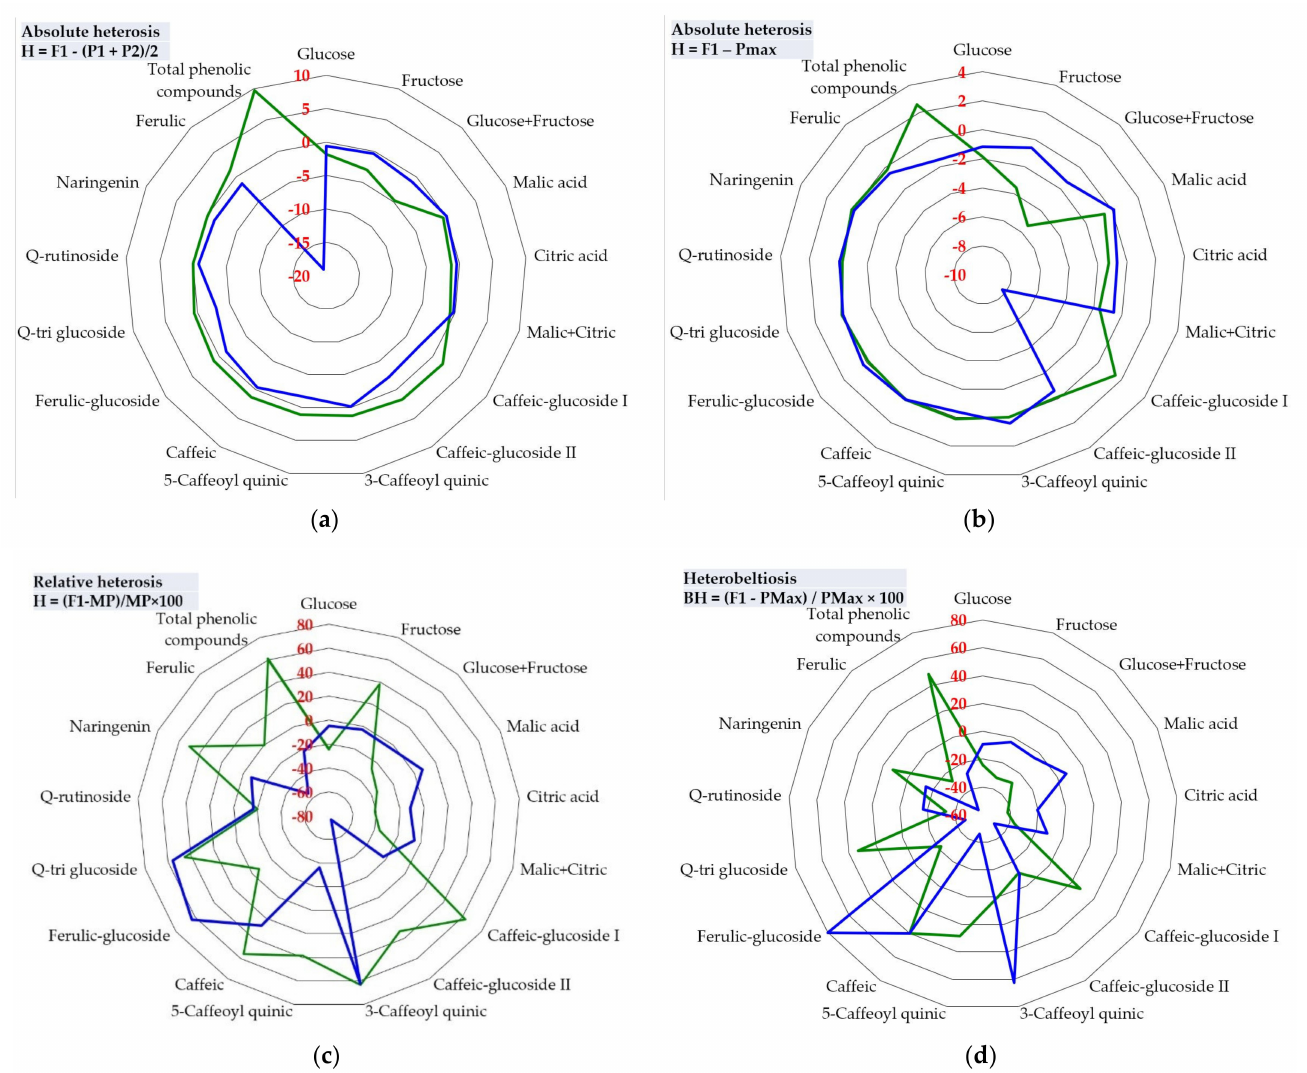
Figure 4. Value of heterosis and its direction (positive or negative) for the main chemical components of tomatoes, depending on the type of heterosis calculated for two newly commercial hybrids and their parental lines in F7: ( a ) Absolute heterosis, based on the average value of the parents; ( b ) Absolute heterosis, based on the average value of the best parent; ( c ) Relative heterosis; ( d )